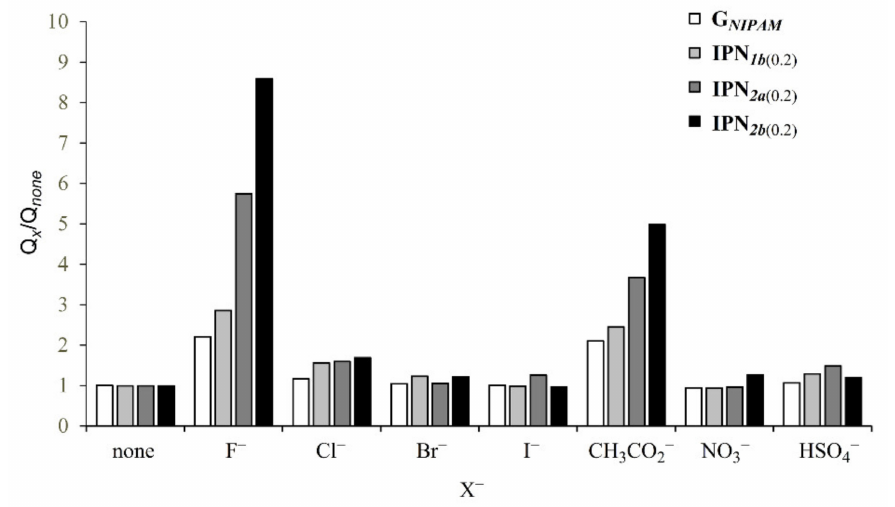
Figure 6. Relative swelling degree ratio ( Q x / Q none ) of G NIPAM (Table 2, run 1), IPN 1b(0.2) (run 6), IPN 2a(0.2) (run 8), and IPN 2b(0.2) (run 10) in the presence of TBAX (20 mM) in DMF (25 ◦ C).